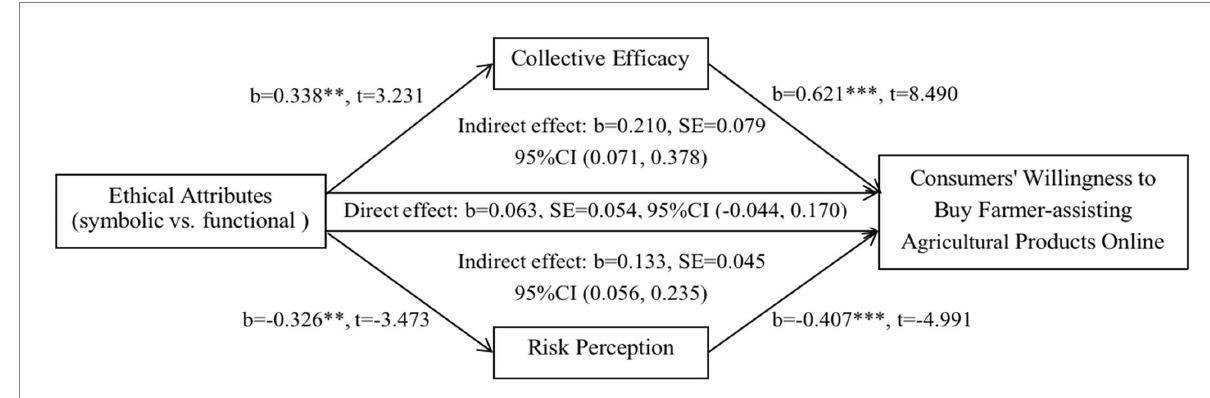
FIGURE 4 Statistical mediation diagrams for collective efficacy and risk perception. ** p < 0.01, *** p <